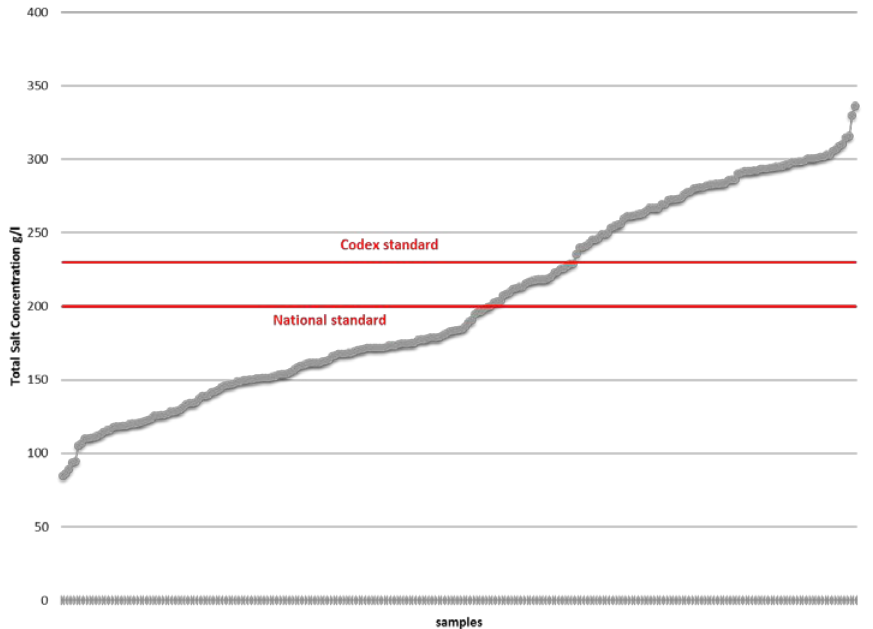
Figure 4. Salt values (g/L) in fish sauces (sorted by lowest to highest salt value).